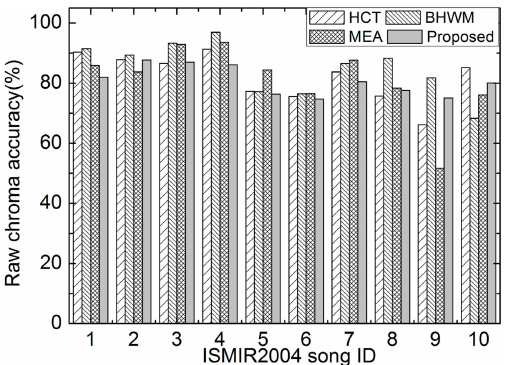
Figure 7. Raw chroma accuracies of different methods on ISMIR2004.